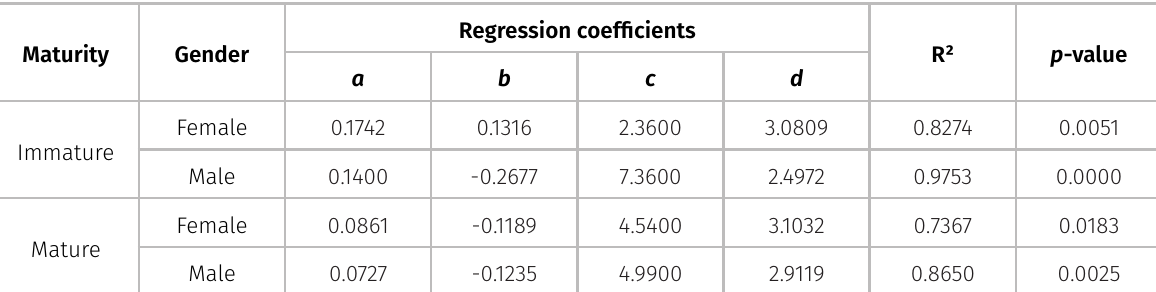
Table III. Sine-cosine models’ statistics (equations, determination coefficients (R²) and p -values) of allometric coefficients variation over time (see Figure 2). Equation coefficients ( a , b , c and d ) refers a general sine-cosine equation: , where a and b control the wave range, c is half of the wave T period and d is the the long-term mean of the allometric